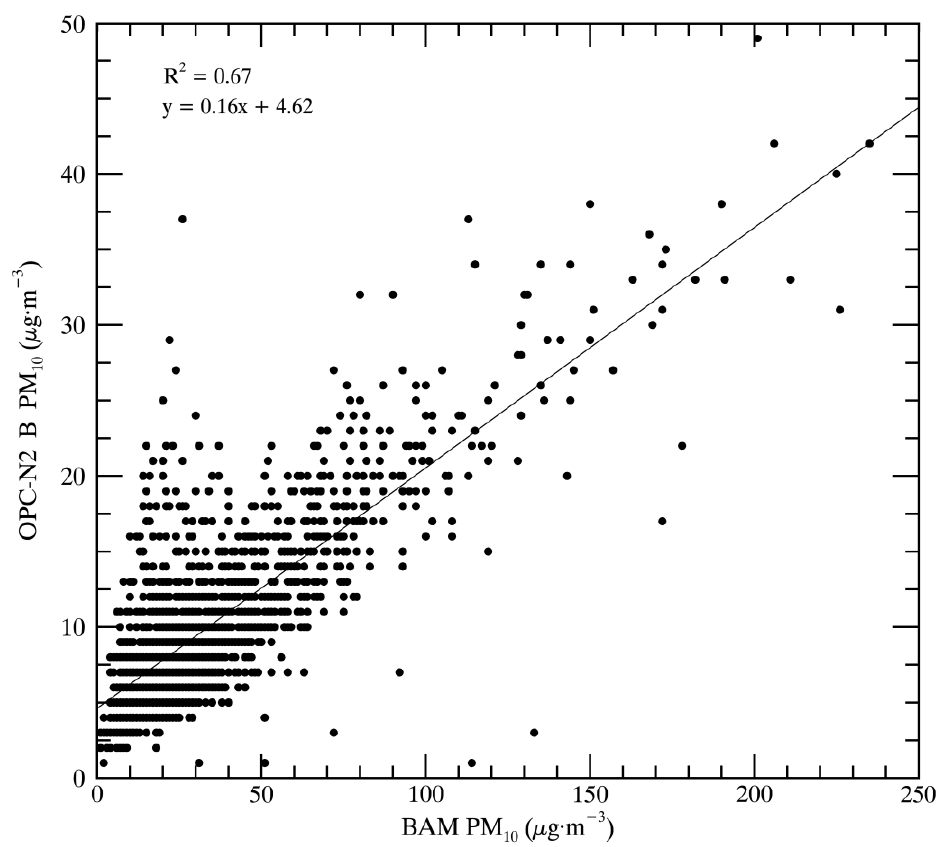
Figure 5. Correlation and regression of OPC-N2 B and BAM-measured PM 10 .